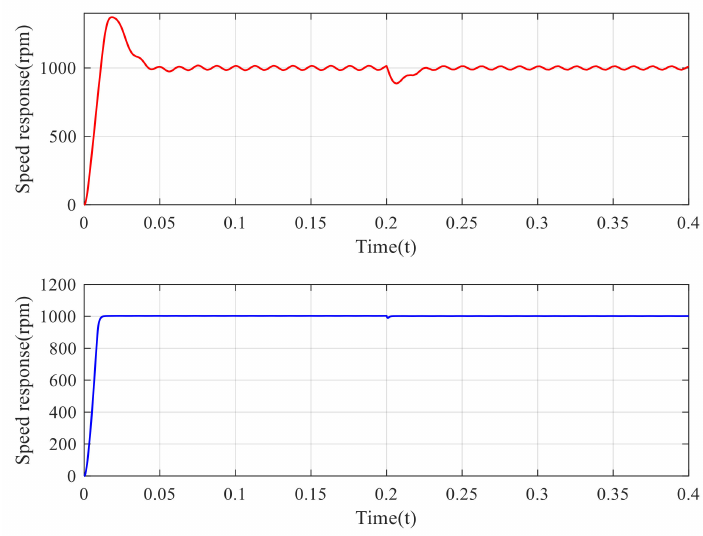
Figure 6. The speed response results without compensation and with compensation in high-speed condition (the blue line indicating the speed response results with compensation, and the red line indicating the speed response results without compensation).